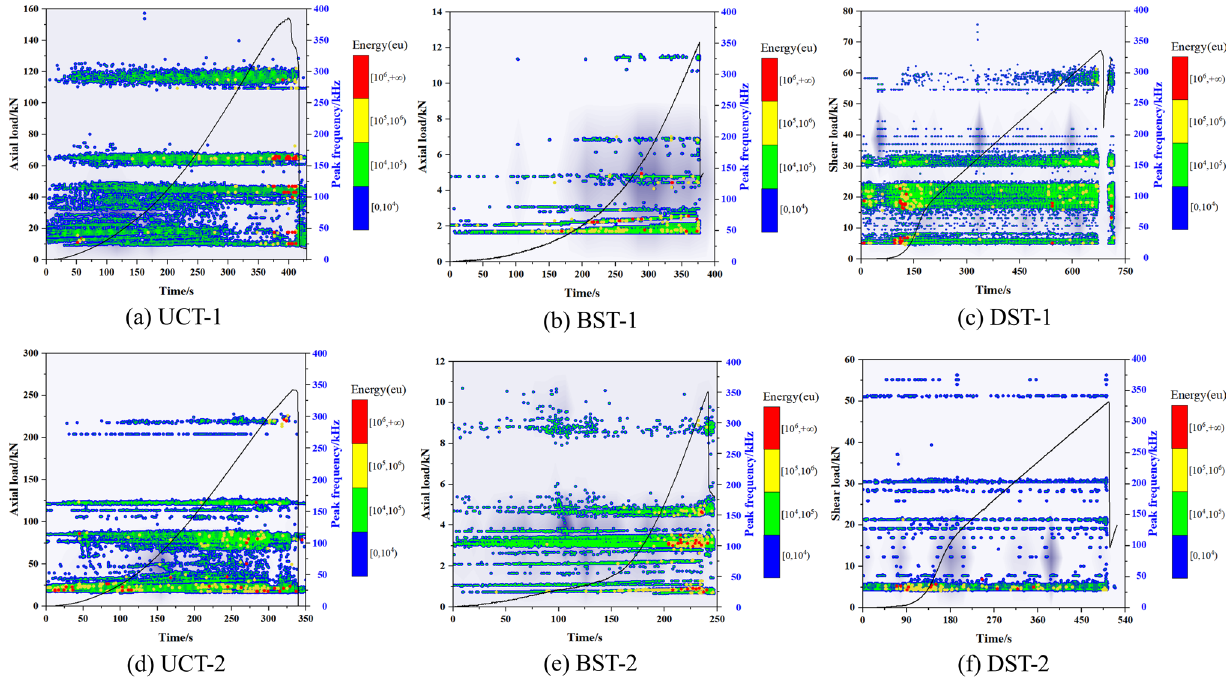
Fig. 7 Distribution of AE peak frequency: a UCT-1; b BST-1; c DST-1; d UCT-2; e BST-2; f